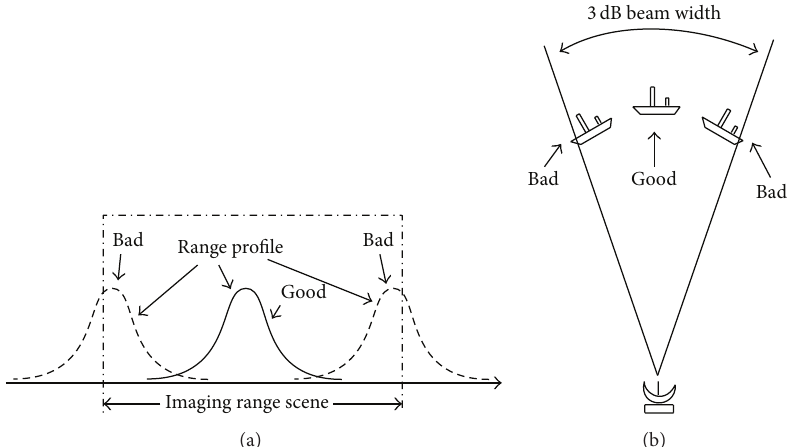
Figure 1: Different positions of the target. (a) Different positions of the target in the imaging range scene. (b) Different positions of the target in the radar antenna beam.